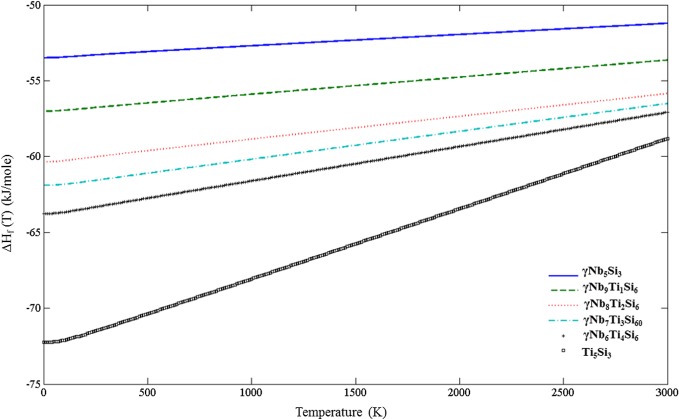
Enthalpies of formation of the D88 silicides.